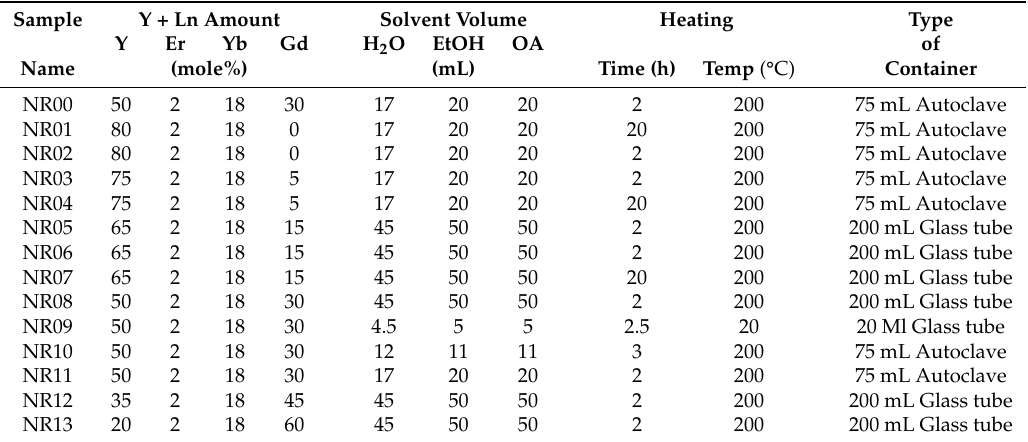
Table 1. Summary of all the synthesis